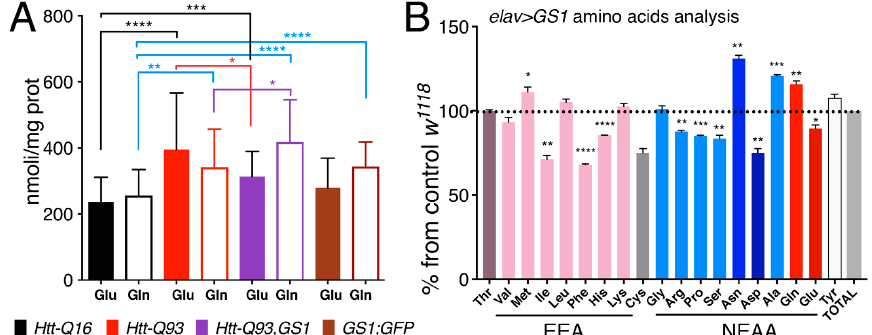
Figure 7 . Expression of GS1 in neurons reduces glutamate Glu and increases glutamine Gln, and influences amino acid levels. ( A ) Quantification of glutamate (Glu) and glutamine (Gln) from heads was analyzed by MS/HPLC in lysates from animals of the indicated genotypes. ( B ) Amino acids profiling from heads of animals expressing GS1 in neurons; the data are indicated as the % of the amino acids concentrations in GS1 versus the relative concentration in lysates from control w 1118 animals. 20 animals for each genotype were used. EAA = essential amino acids, NEAA = non-essential amino acids. The **** p < 0.0001, *** p < 0.001, ** p < 0.01, * p < 0.05 values were calculated from Student’s t -test from at least three independent experiments; the error bars indicate the standard deviations.